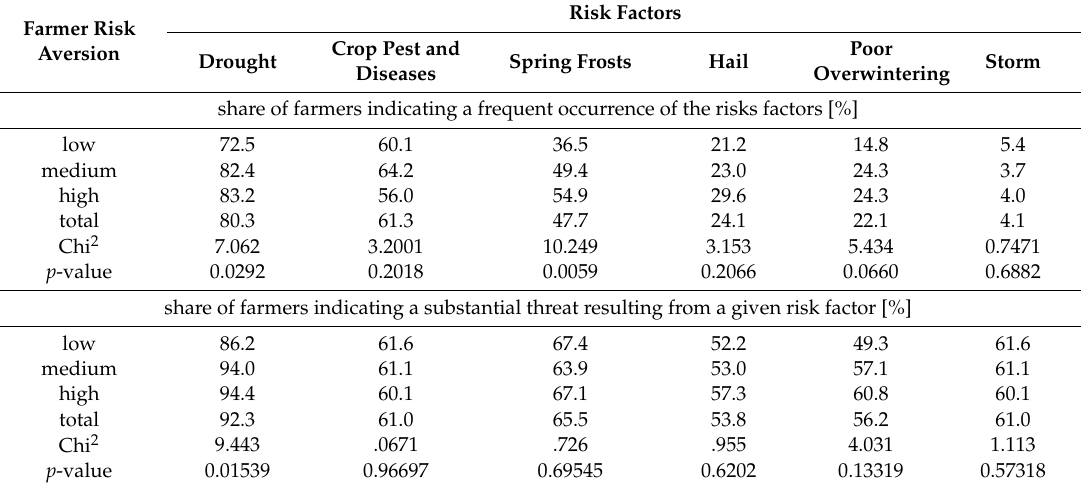
Poor Storm Overwintering